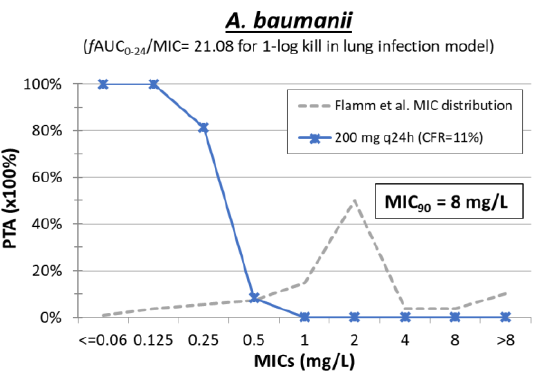
Figure 7. Probability of target attainment (PTA) of minocycline against isolates with increasing MIC. The cumulative fraction of response (CFR) for A. baumannii is shown for a collection of MDR isolates with MIC distribution by Flamm et al [37].